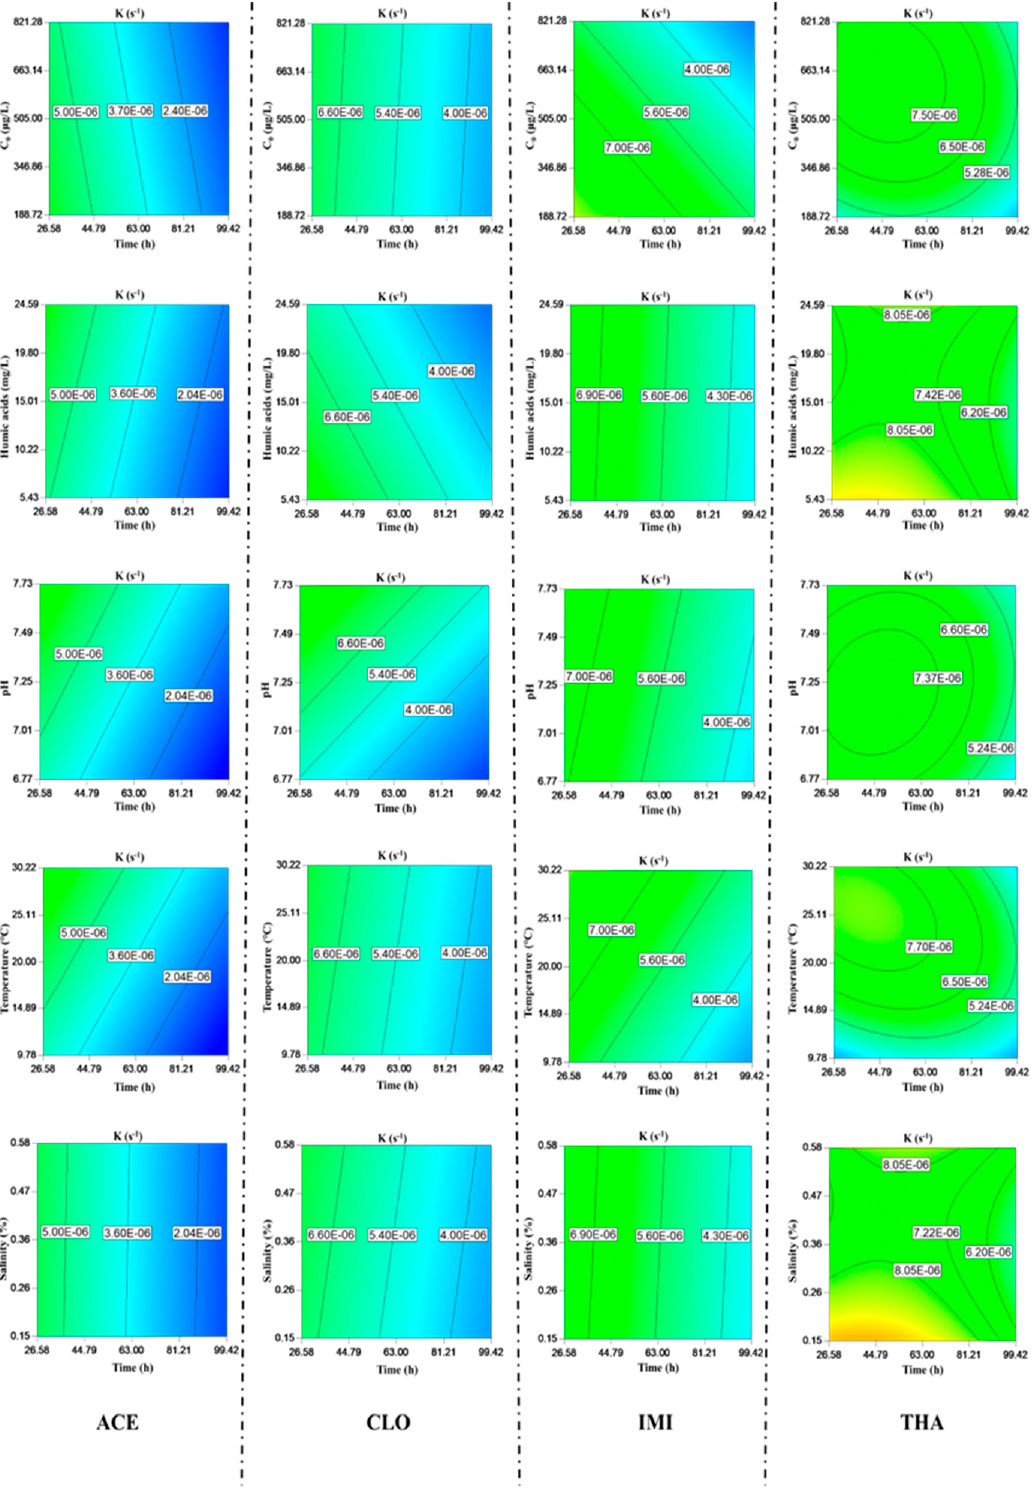
Figure 4. Biodegradation rates of four typical NEOs and environmental parameters affecting NEO biodegradation